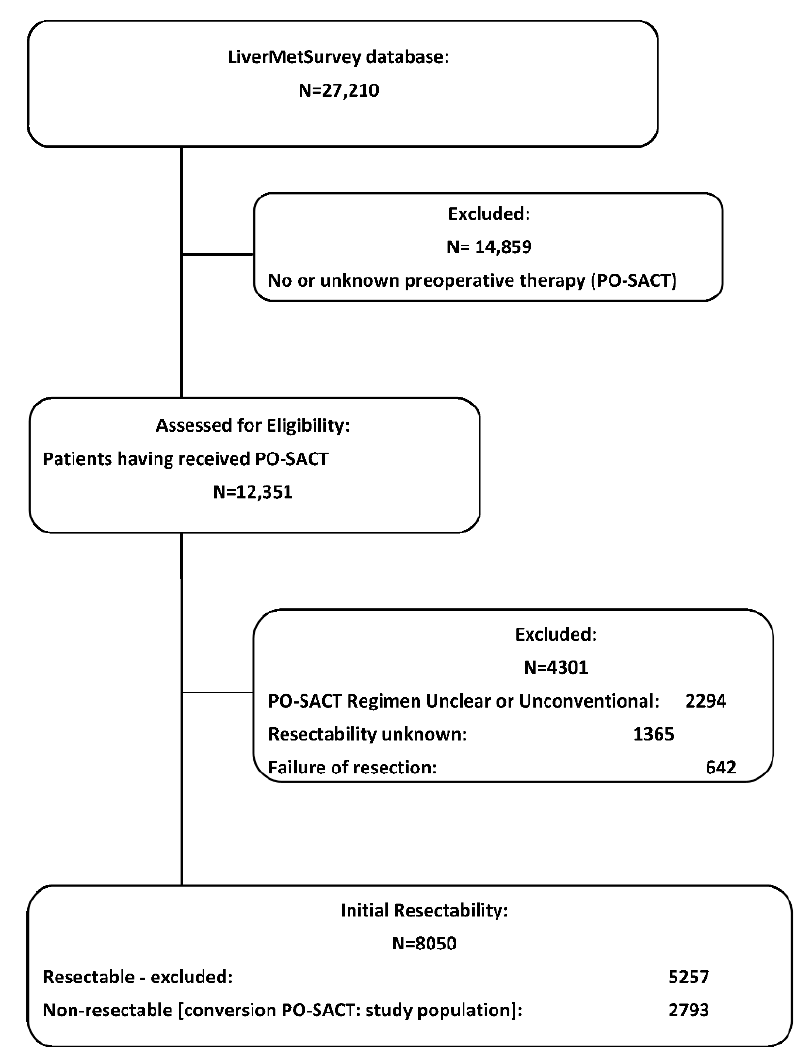
Figure 1. Study Flowchart (CONSORT diagram). PO-SACT: pre-operative systemic anticancer therapy; CONSORT: consolidated standards of reporting trials.